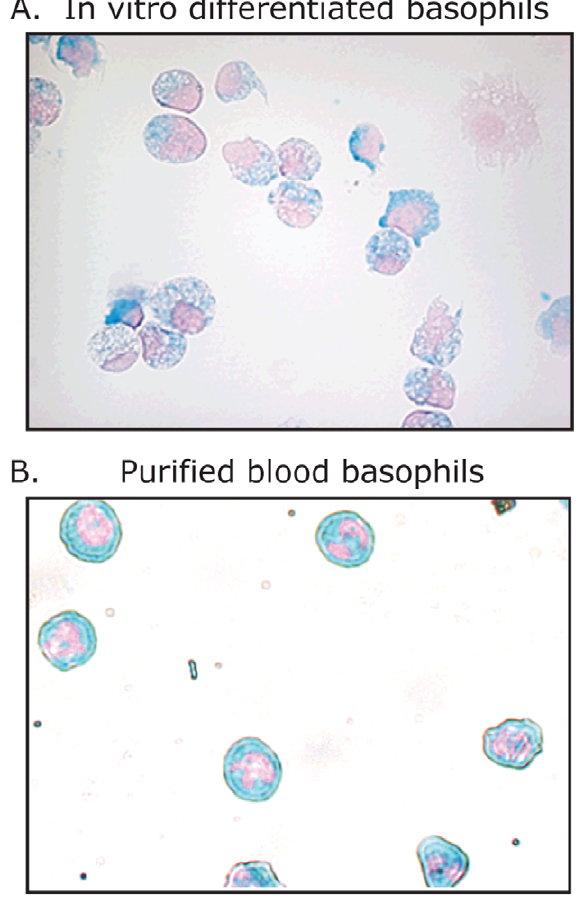
Figure 1. Alcian blue staing of invitro differentiated basophils and normal blood basophils. Panel A shows Alcian blue stained cells from day 9 of in vitro differentiated basophils originating from umbilical cord blood cultures stimulated with a continuous presence of 10 ng/ml IL-3. Panel B shows Alcian blue stained normal purified peripheral blood